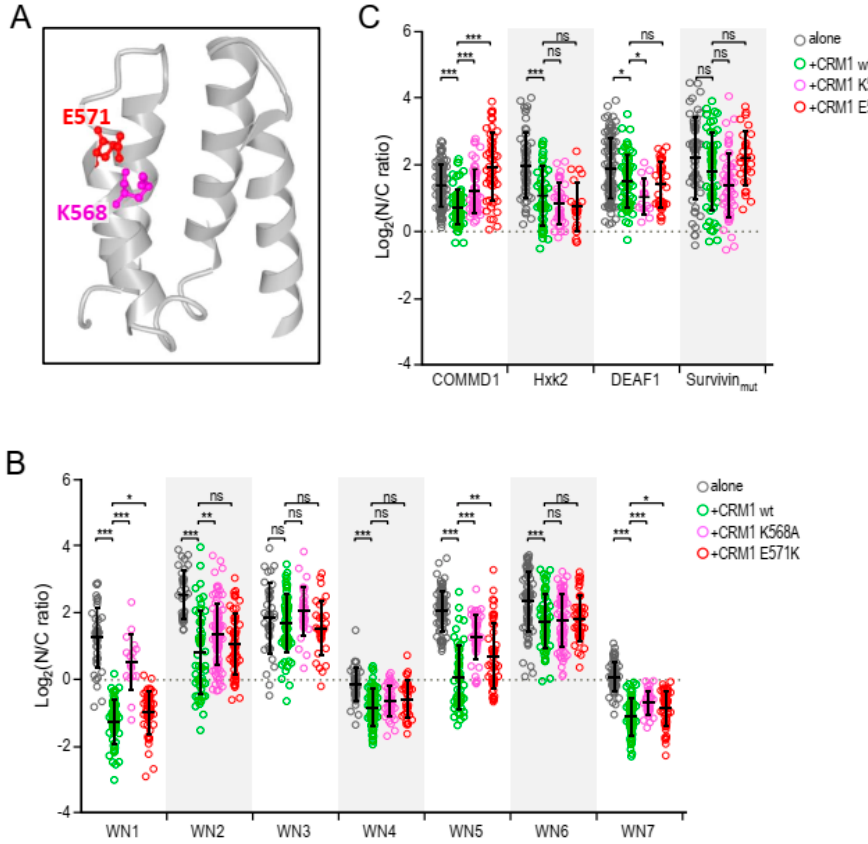
Figure 4. Using the SRV B/A assay to compare the effect of E571 and K568 mutations ( A ) View of CRM1 NES-binding groove generated with NCBI iCn3D viewer using PDB structure 3GJX [15]. The E571 and K568 residues are highlighted using ball and stick representation, while the remaining residues are represented using ribbon style. ( B ) Graph representing the nucleocytoplasmic localization of three SRV B/A reporters containing “inactive” NES motifs (COMMD1, Hxk2 and DEAF1) [11], plus an export defective mutant of survivin NES (Survivin mut ), when expressed alone or when co-expressed with YFP-CRM1 (wild-type, K568A or E571K). ( C ) Graph representing the nucleocytoplasmic localization of seven SRV B/A reporters containing NES motifs identified in cancer-related proteins (WN1-7) when expressed alone or when co-expressed with YFP-CRM1 (wild-type, K568A or E571K). In the graphs shown in panels ( B ) and ( C ), each circle represents a single cell where the nuclear to cytoplasmic (N/C) ratio of the fluorescent signal corresponding to the reporter was determined by image analysis using Fiji. The mean (+/ − SD) is also shown. The level of statistical significance of the differences between the compared samples (Mann-Whitney U test) is indicated by the asterisks as follows: (*) p < 0.05; (**) p < 0.01; (***) p > 0.001; ns, non-significant.